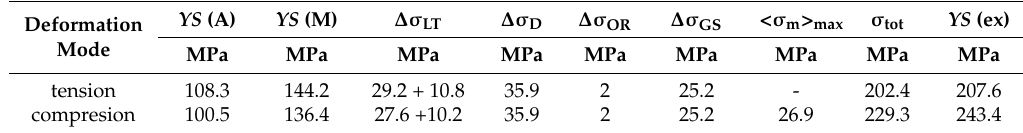
Table 5. Individual contributions to strengthening of the hybrid composite.